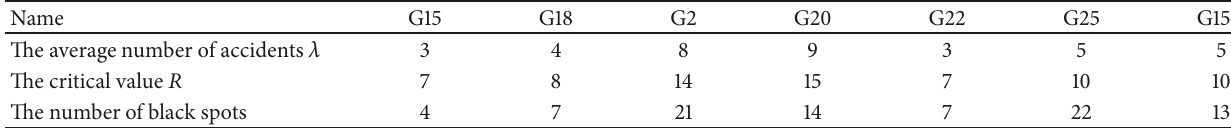
Table 4: The result of the identification of black spots in the study area.